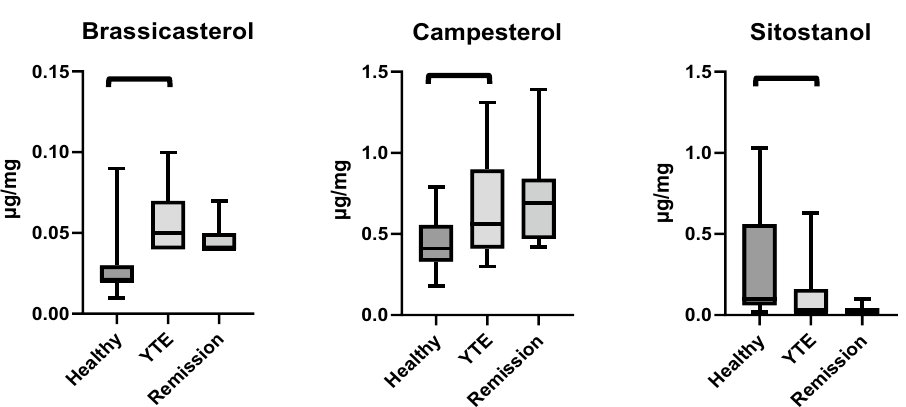
Figure 3. Box plots comparing fecal concentrations of brassicasterol, campesterol, and sitostanol in healthy controls, dogs with YTE, and dogs with YTE after achieving clinical remission. Square brackets are indicating significant differences between groups. Box plots represent the 25–75th percentile; the median is shown as the heavy dark horizontal line. Vertical lines extend to the minimum and maximum values. YTE, Yorkshire Terrier